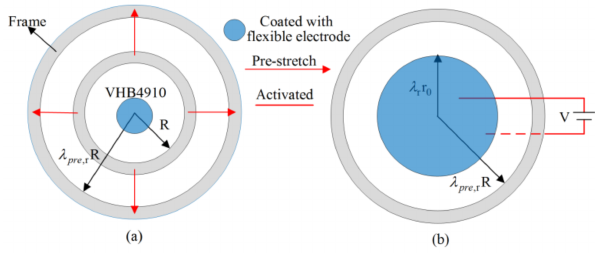
Figure 10. Working principle of a circular dielectric elastomer actuator [47]: ( a ) Pre-stretched state; ( b ) Activated state.